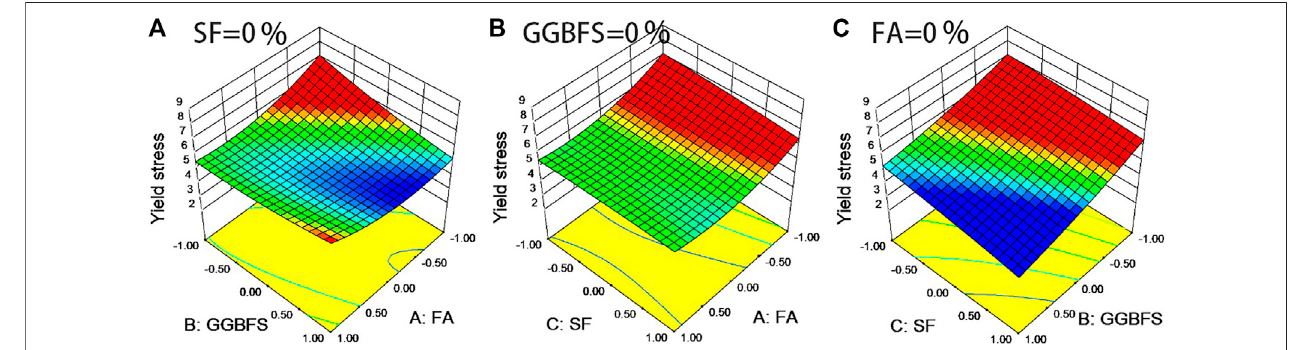
FIGURE 9 | The combined effect of SCMs on yield stress of nano-silica modi fi ed cement-based paste.